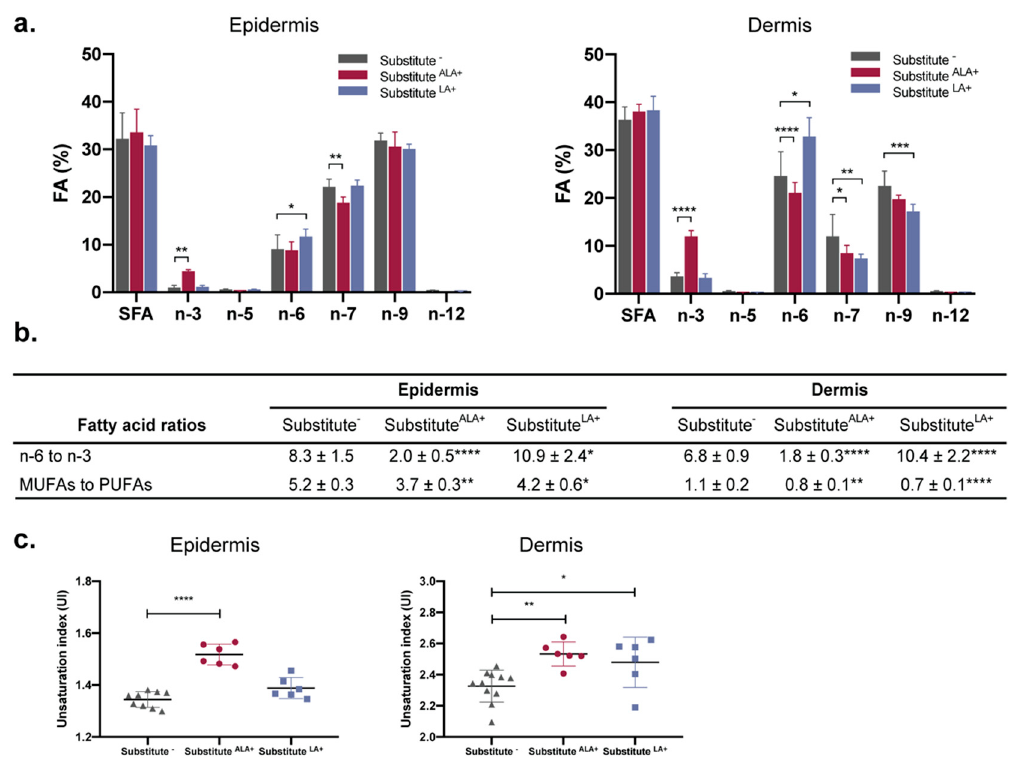
Figure 4. Proportions of FAs in the skin substitutes quantified by gas chromatography. ( a ) FA classes are shown as a percentage of total FAs detected in phospholipids of the epidermis or the dermis. ( b ) Phospholipid FA ratios in the epidermis or the dermis of the skin substitutes. ( c ) UI of the phospholipid FAs in the epidermis and the dermis. For Substitute − : n = 11 (3 donors, 3-4 skin substitutes per donor); for Substitute ALA + and Substitute LA + : n = 6 (3 donors, 2 skin substitutes per donor). ( a ) Two-way ANOVA followed by Tukey’s post-hoc test. ( b , c ) One-way ANOVA followed by Tukey’s post-hoc test. * p < 0.05; ** p < 0.01; *** p < 0.001; **** p < 0.0001. Abbreviations: ALA, α -linolenic acid; FA, fatty acid; LA, linoleic acid; MUFAs, monounsaturated fatty acids; PUFAs, polyunsaturated fatty acids; SFA, saturated fatty acid; UI, unsaturation index.